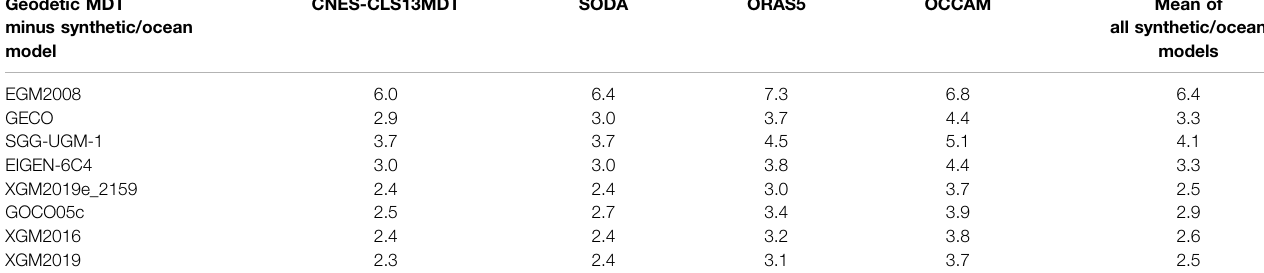
TABLE 4 | The standard deviation of the differences between the MDTs derived from different GGMs and synthetic/ocean model.